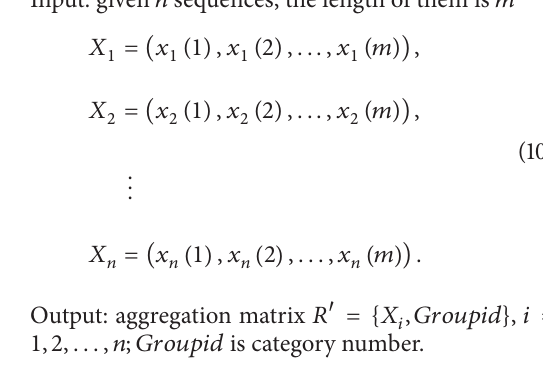
Algorithm 6 (unsupervised fast grey clustering based on grey relational